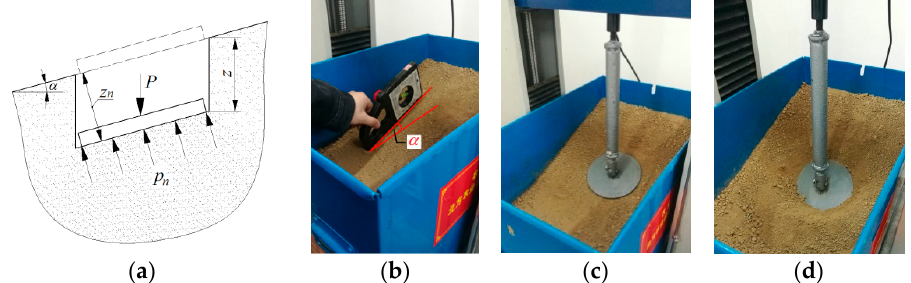
Figure 6. Test of improved Bekker’s pressure–sinkage model under sloped terrain conditions. ( a ) Test principle; ( b ) Slope Angle measurement; ( c ) Before applying pressure; ( d ) After applying pressure.